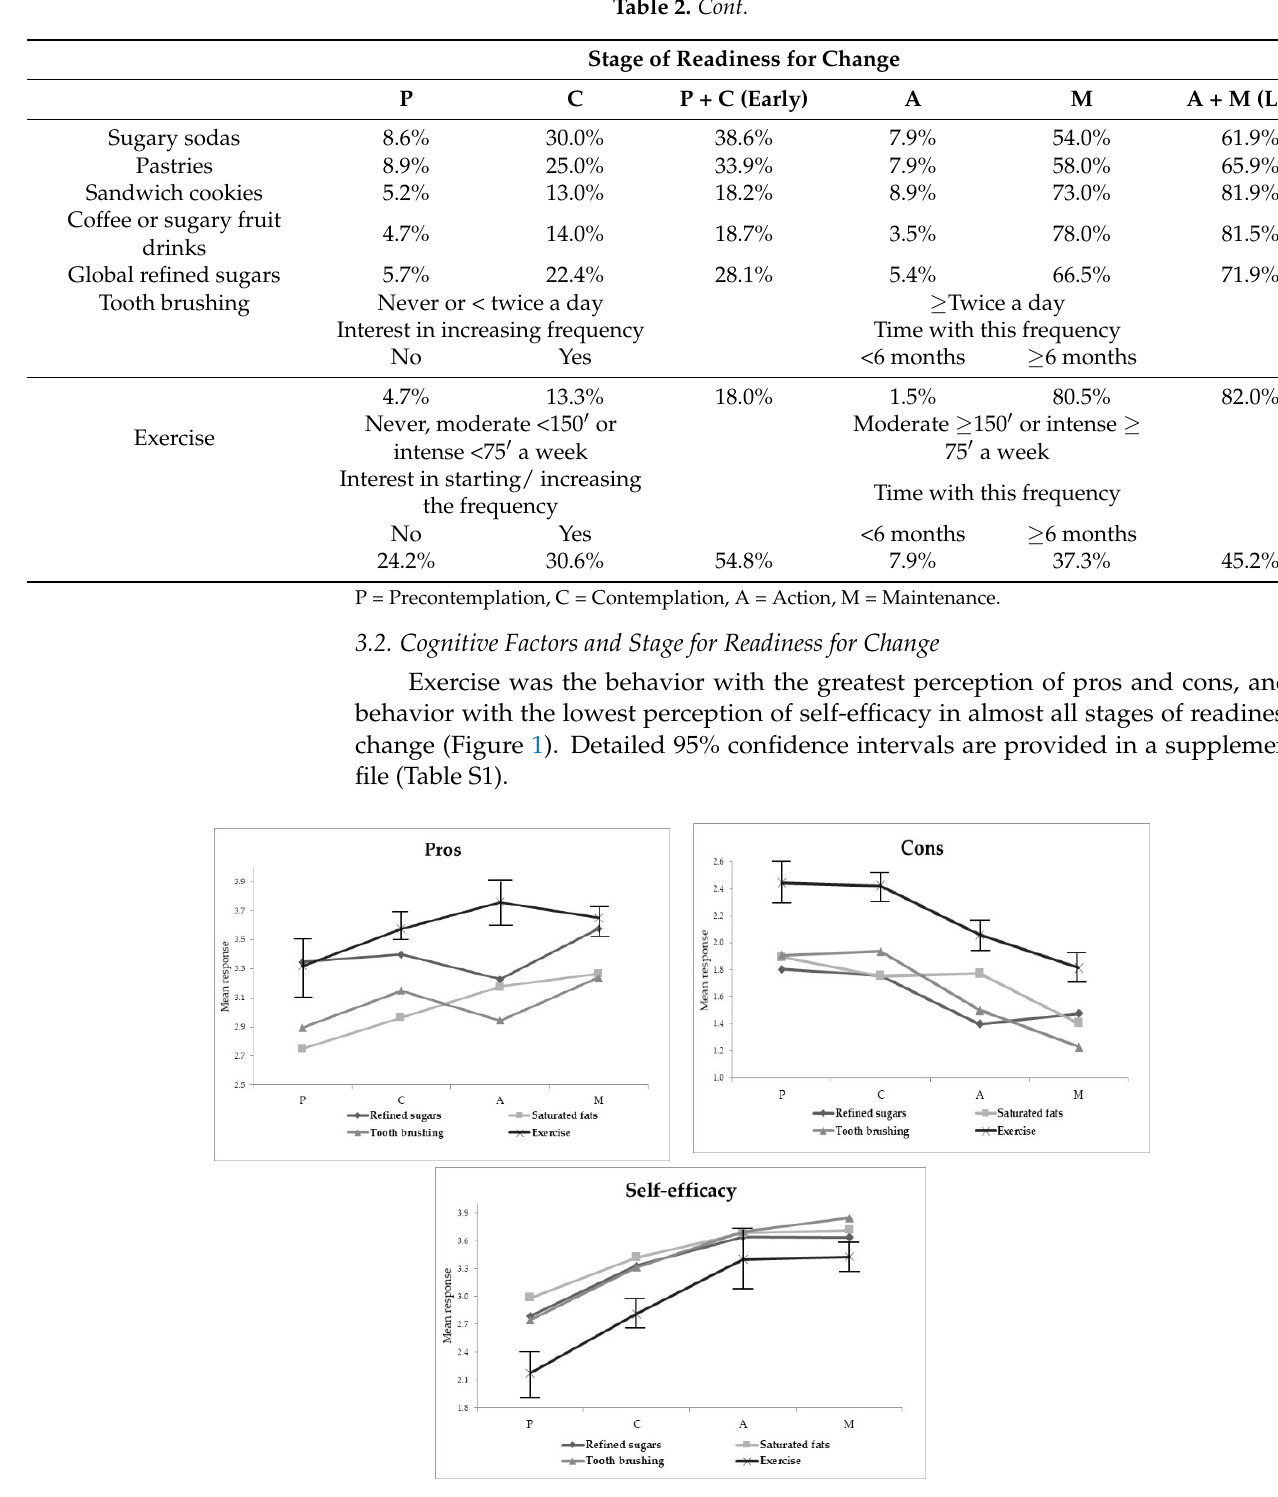
Figure 1. Mean and 95% confidence intervals of perception of pros, cons, and self-efficacy, patients with type 2 diabetes treated in primary care ( n = 406) (the higher the score, the greater the perception). P = Precontemplation, C = Contemplation, A = Action, M = Maintenance.